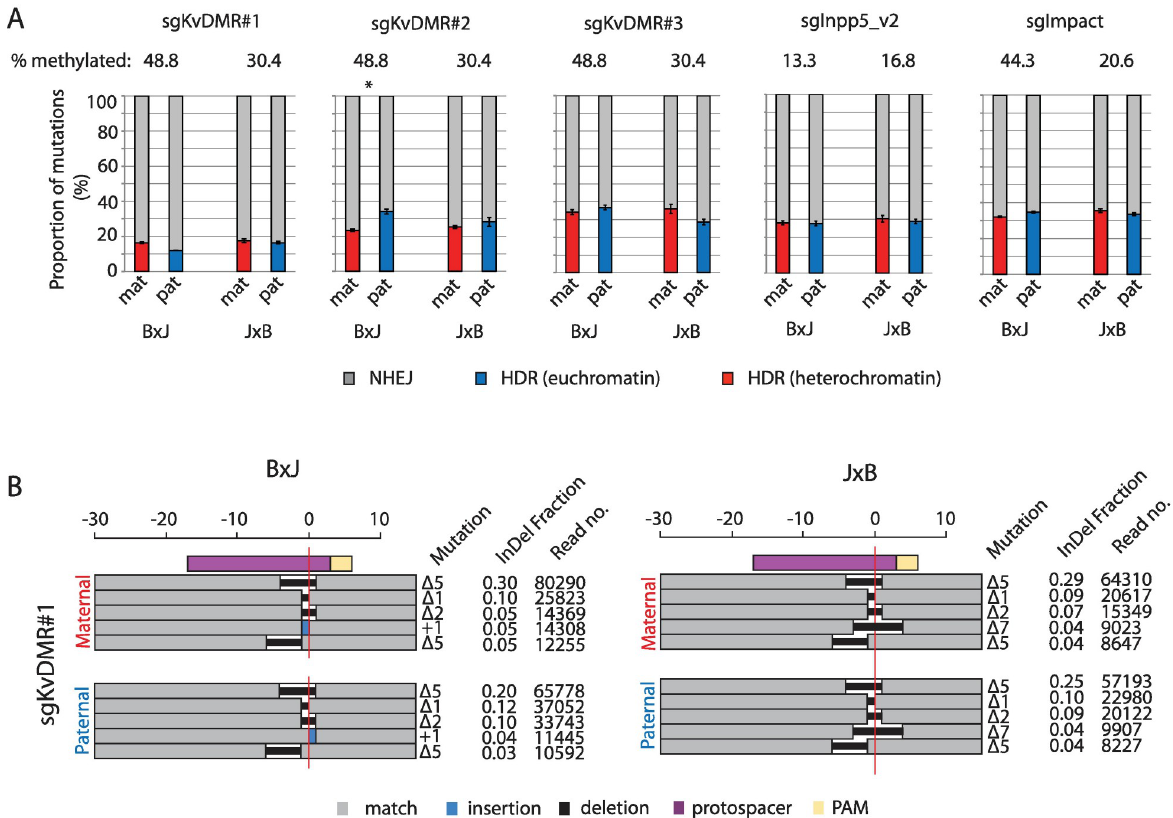
Fig 6. The ratio of InDels to precise sequence edits is unaffected by heterochromatin. (A) The relative frequency of mutations arising from NHEJ versus HDR in cells collected at 96 hours post transfection for five sgRNAs with target sites within imprinted heterochromatin (S1A, S2A and S3A Figs). The percentage of hypermethylated ( > 80%) strands in mock-transfected cells is indicated above the plot. Asterisk denotes Bonferroni- corrected p < 0.05 from paired t tests of difference between HDR frequencies on maternal versus paternal alleles. (B) The size and frequency of the top five most common InDels 96 hours following transfection with sgKVDMR#1 (S1A Fig), broken down by parental allele. The horizontal red line denotes the predicted cleavage site. Deletion sizes are depicted against the scale bar at the top, and for insertions, the number of inserted bases is indicated next to the blue rectangle. Note that different +1 nucleotide insertions were observed and are represented as blue rectangles on opposite sides of the cleavage site. The fraction of Indels was calculated as the number of reads corresponding to each specific mutation expressed as a proportion of all InDel-containing reads. Quantitative data underlying both panels are provided in S1 Data, and details of MiSeq libraries including SRA accessions are provided in S2 Data. HDR, homology-directed repair; InDel, Insertion or deletion; mat, maternal; NHEJ, nonhomologous end joining; PAM, protospacer adjacent motif; pat, paternal; sgRNA, single guide RNA; SRA, Sequence Read Archive.